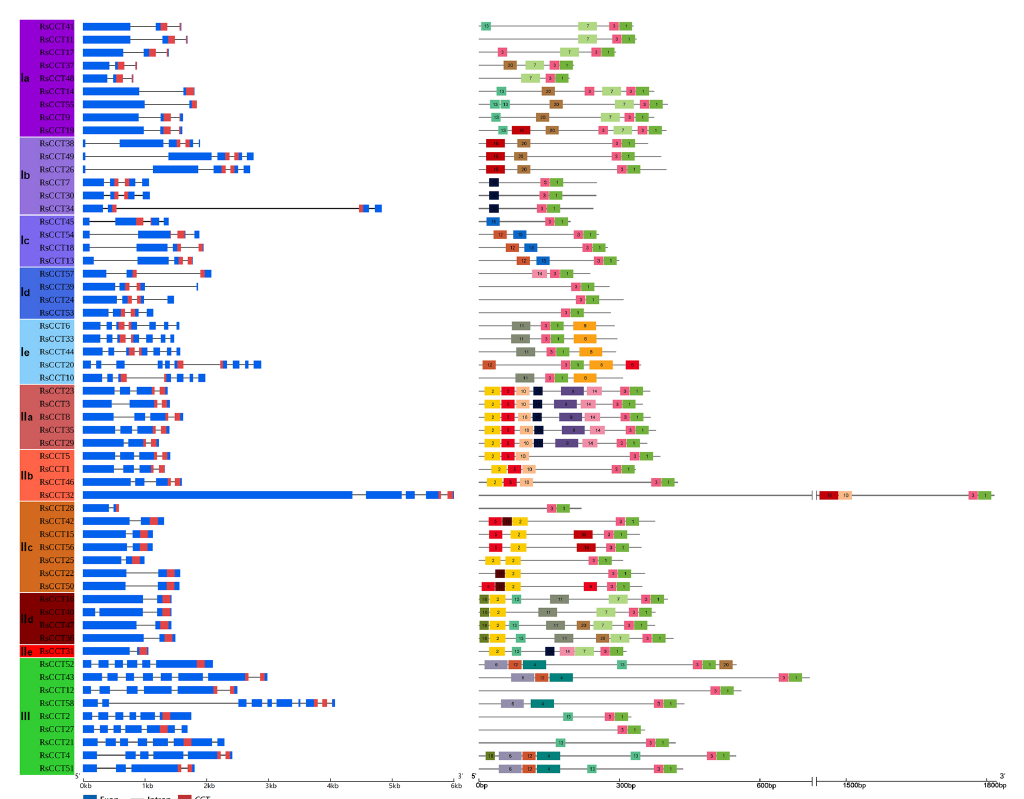
Figure 3. Gene structure and conserved motifs of RsCCT . Different subgroups of RsCCT genes are highlighted in different colors. The gene structure of RsCCT genes was generated from the GSDS website. The blue block represented the coding sequence (CDS) while the black line indicated the introns. The red square represented the location of the CCT conserved domain. The conserved motifs in RsCCT proteins were identified through the MEME software. Different colored blocks represented different